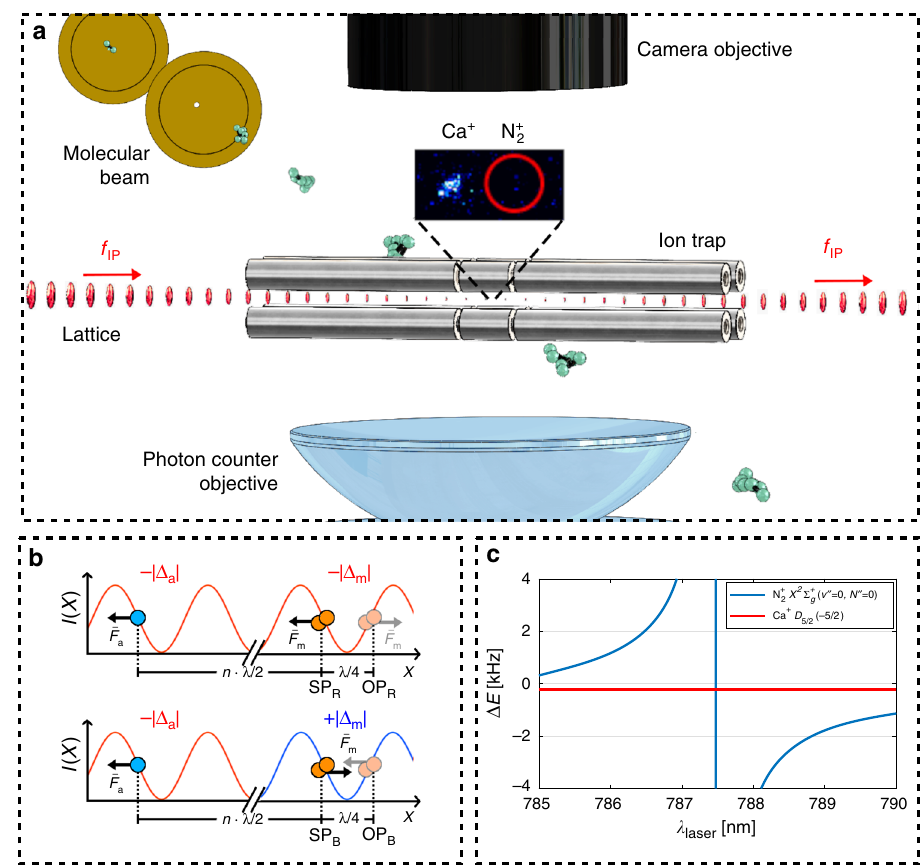
Fig. 1 Experimental scheme. a A pulsed molecular beam of neutral N 2 molecules traversed the centre of a linear radiofrequency ion trap. A single 14 N þ molecular ion was generated from the molecular beam by photoionization and was trapped together with a single laser-cooled 40 Ca + ion (inset). A running-wave optical lattice generated from two counter-propagating laser beams with frequency difference Δ f = f IP was overlapped with the two-ion crystal to excite motion depending on the molecular state. The Ca + ion enabled sympathetic cooling of the N þ motional state and provided a reference for the phase-dependent method presented here. b Four possible con fi gurations (SP R/B , OP R/B ) of the lattice containing the atomic ion (AI, blue circle) and the molecular ion (MI, orange circles). The direction of the force on the MI (AI) ( F m(a) ) was determined by the frequency detuning ± ∣ Δ m(a) ∣ of the lattice laser beams from resonance and the relative positions of the particles in the lattice fi eld. The AI and the MI had either the same signs of detuning (top) or opposite signs (bottom). For an MI at positions SP R and SP B in the lattice, the distance between the two ions was such that they experienced the same phase (SP), while at positions OP R and OP B the ions experienced opposite phases (OP) of the lattice intensity gradient. c The ac-Stark shift, Δ E , experienced by the AI in the (3 d ) 2 D 5/2 ( m = − 5/2) (red) and the MI in the X 2 Σ þ function of lattice wavelength in the region 785 – 790 nm. The direction of the ac-Stark shift switches sign when changing from negative to positive detuning across a molecular resonance while the ac-Stark shift experienced by the AI remains constant in this wavelength